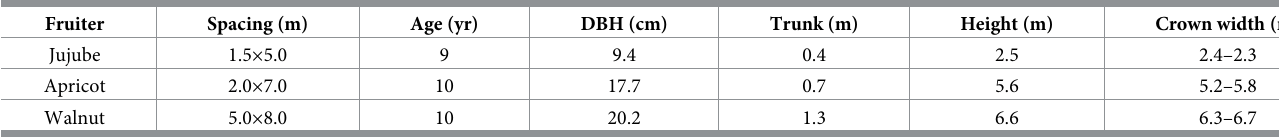
Table 1. The basic information of the 3 fruit